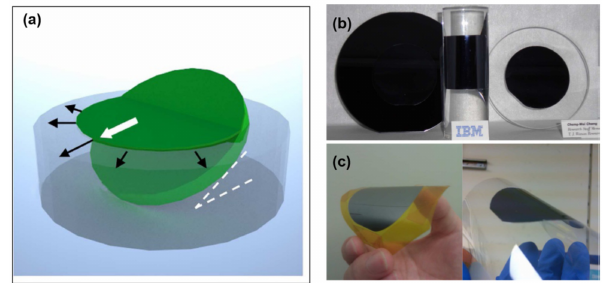
Figure 2. ( a ) Sketch of surface tension-assisted epitaxial lift-off (ELO) transfer techniques. ( b ) Demon- strations of the transferred GaAs thin films to the rigid substrate (left image, GaAs on 4 (cid:48)(cid:48) Si wafer. Center image, GaAs on curved solid object. Right image, GaAs on glass) and ( c ) flexible substrates (left, GaAs on tape. Right, GaAs on flexible sheet). Adapted from